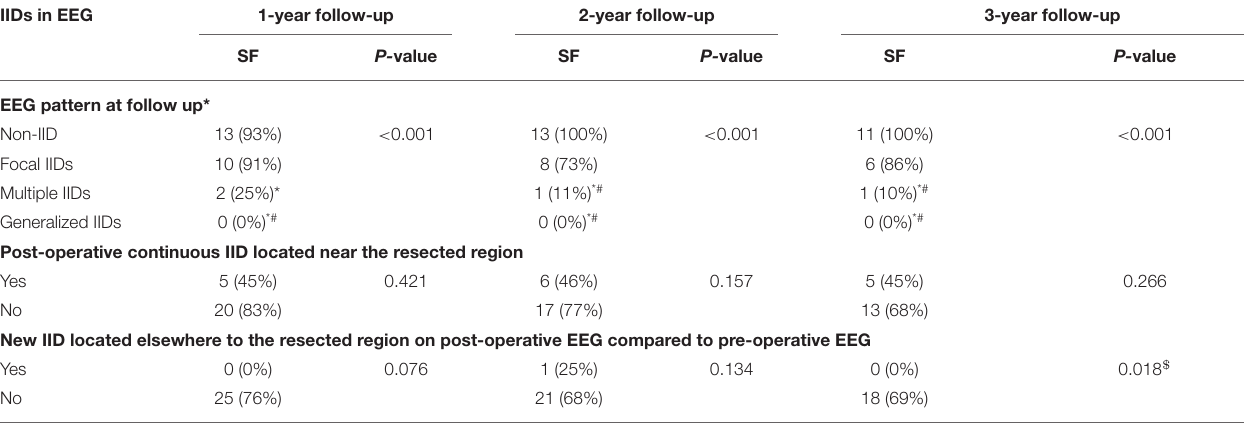
TABLE 3 | Influence of post-operative EEG patterns on post-operative seizure